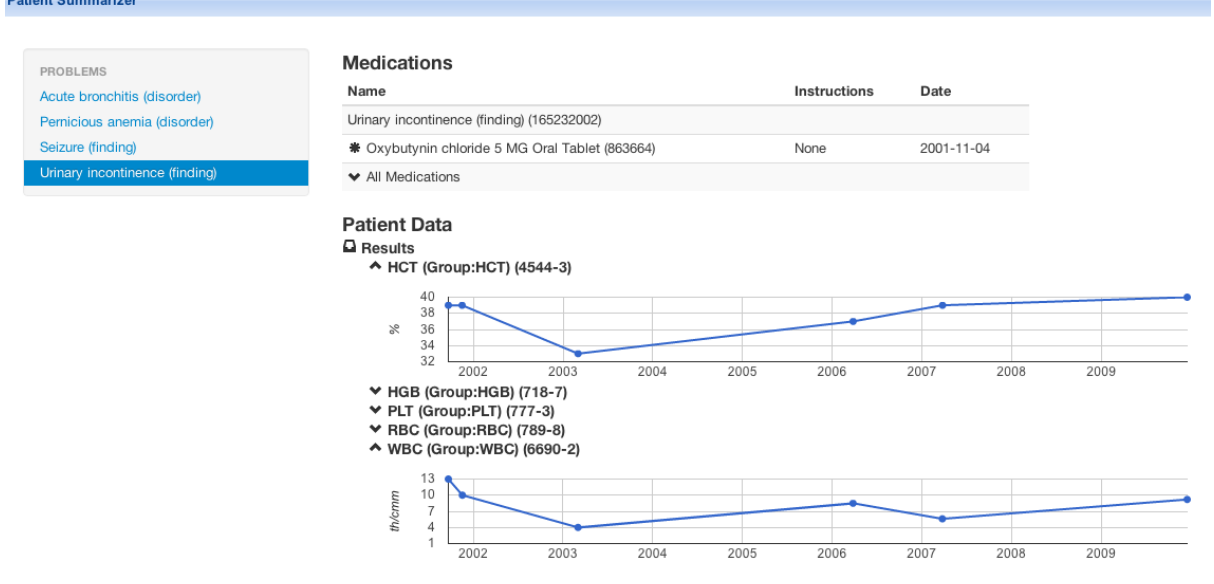
Figure 6. The patient summarization app running inside the SMART-i2b2 container. Shown here: urinary incontinence is highlighted and a relevant medication (oxybutynin) is displayed to the right; lab results are shown as line graphs